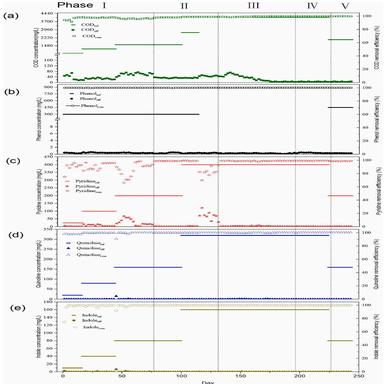
Long-term performance of the SFTIAOB process. (a) COD removal; (b) Phenol removal; (c) pyridine removal; (d) quinoline removal; (e) indole removal.